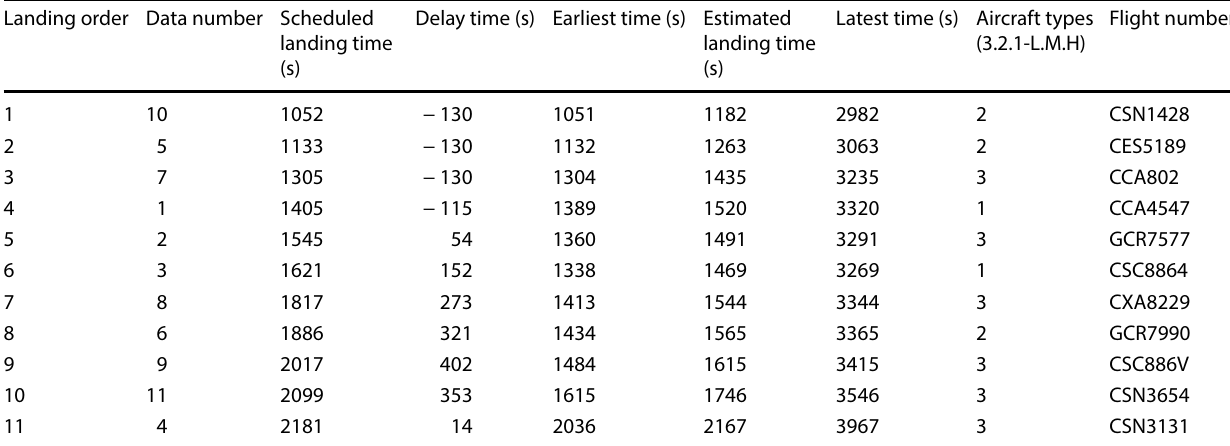
Table 4 Results of test1 by